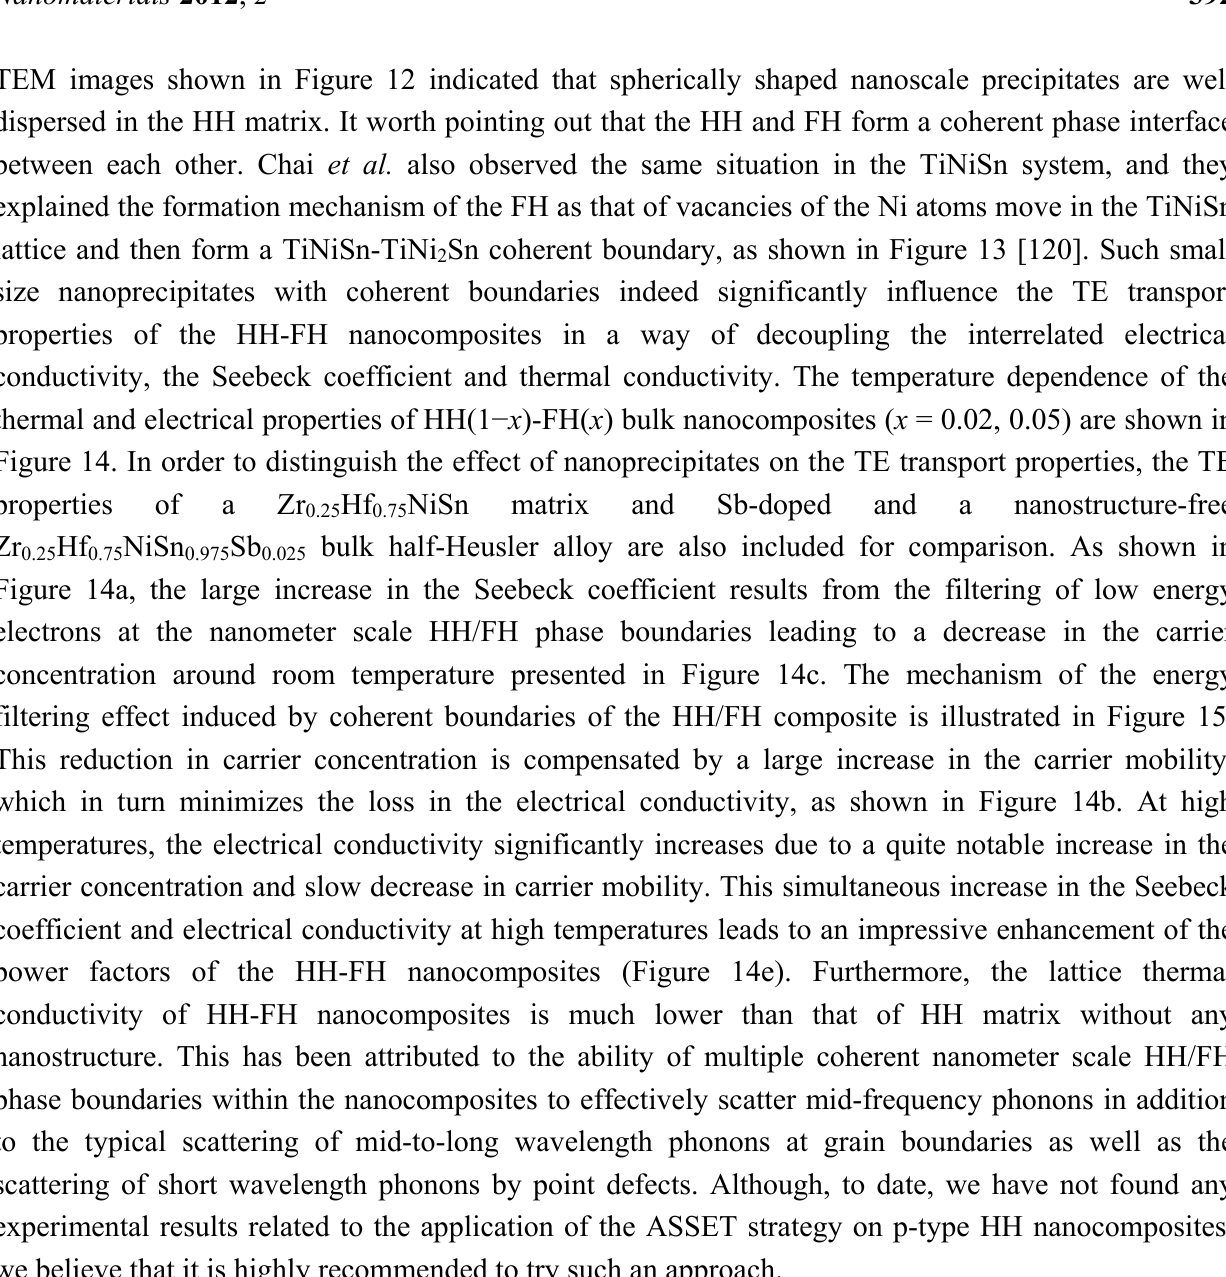
Figure 12. TEM images of spark plasma sintered pellets of HH(1 − x)-FH(x) bulk nanocomposites containing 2 mol% ( A ) and 5 mol% ( B ) FH inclusions. The spherical shape of the precipitates suggests their nucleation and isotropic growth as well as their endotaxial insertion within the HH matrix. In addition to spherical precipitates, 2–8 nm thick and up to 30 nm long lamellar structures are also observed in panel B. High magnification image of one of the lamellar fine features revealed details of the HH-FH phase boundary structure ( C ). The FH and HH phases form a tilted coherent interface with tilt angle of approximately θ = 30°. Fast Fourier Transform (FFT) diffractograms of both HH and FH regions showed that the FH inclusions with unit cell parameter a = 6.29(3) Å is oriented along the [1 -1 -2] zone axis ( D ), whereas the HH matrix with unit cell parameter a = 6.06(3) Å is oriented along [-1 2 1] (Figure 1E). Reproduced with permission